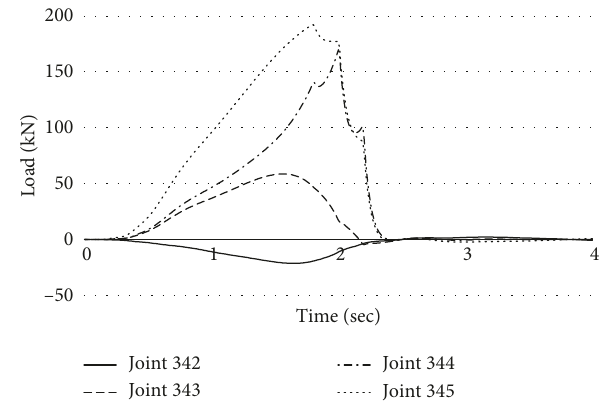
Figure 13: Loads measured by BWIM bearings at the exit side (speed � 80km/h).